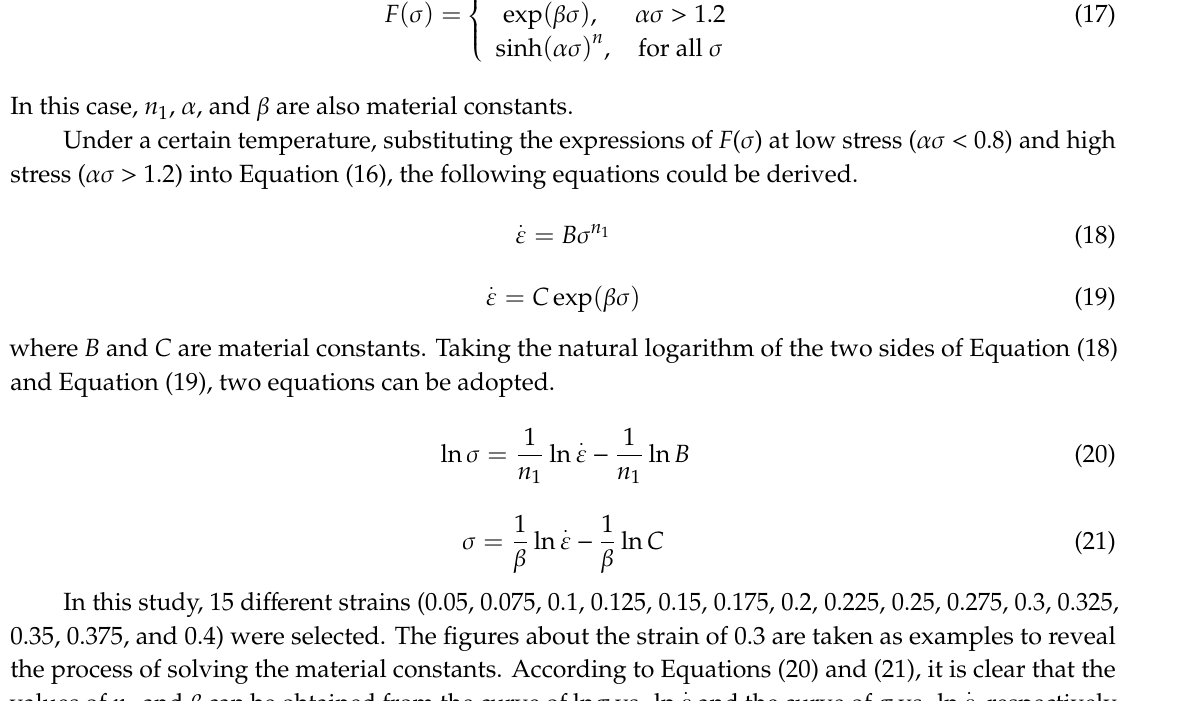
Figure 12. The relation between ln σ and ln ε for five temperatures at the strain of 0.3.